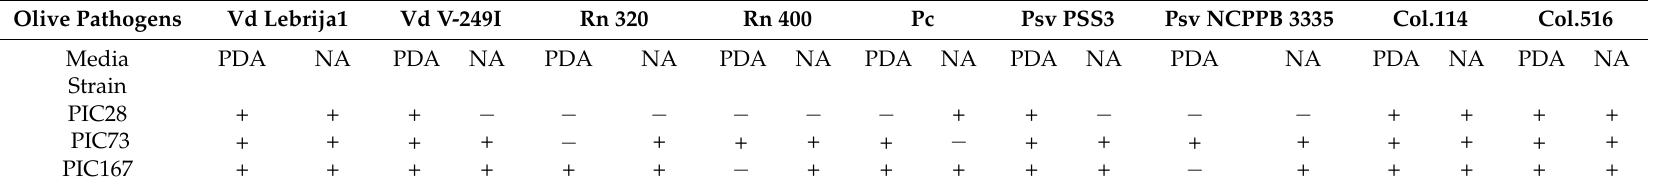
Table 1. Results from in vitro antagonism tests against relevant olive